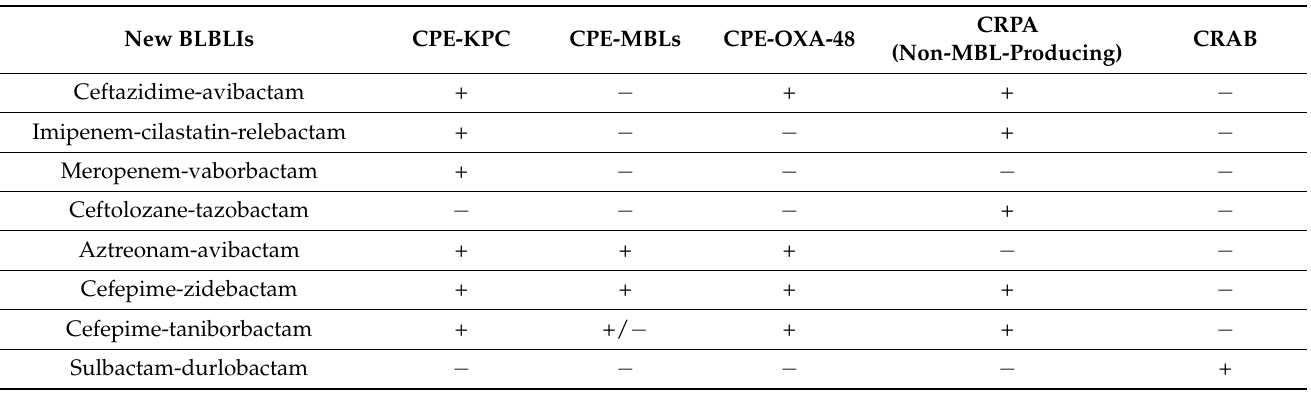
Table 1. List of the new β -lactam β -lactamase inhibitors against target carbapenem-resistant Gram- negative